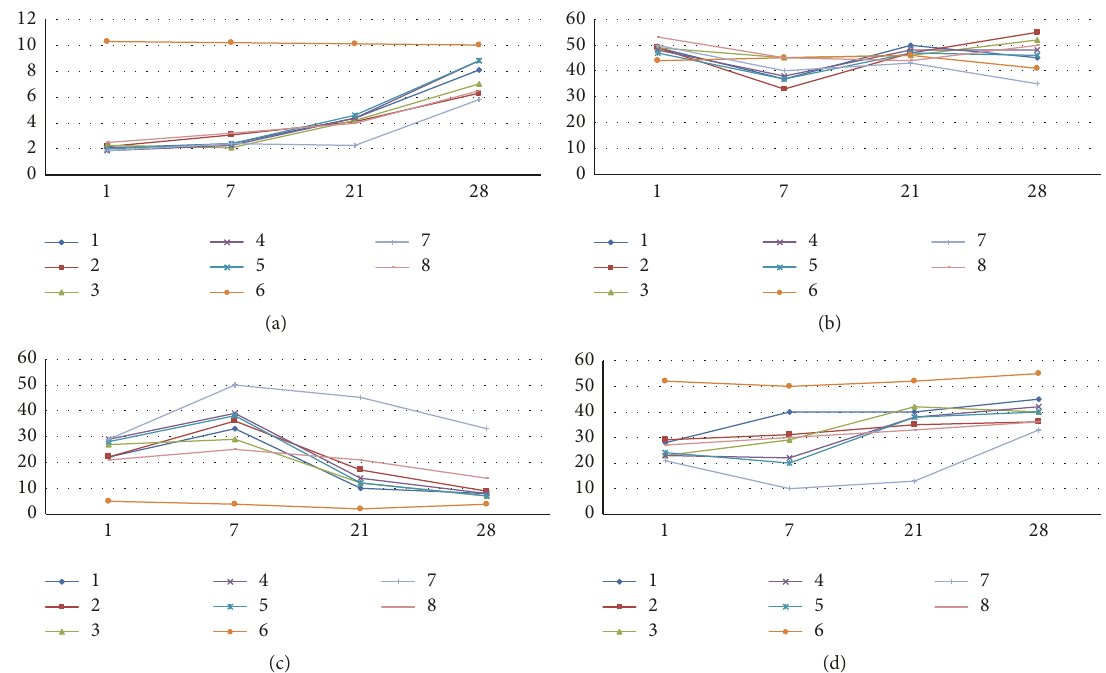
Figure 1: The hemogram of peripheral blood: white blood cells count (a), granulocytic cells (b), eosinophilic and monocytic cells (c), and lymphocytes (d) administration of 10 after the injection of cyclophosphamide solution (1), administration of 7 after the injection of cyclophosphamide solution (2), administration of 6 after the injection of cyclophosphamide solution (3), administration of 8 after the injection of cyclophosphamide solution (4), administration of 9 after the injection of cyclophosphamide solution (5), intact animals (6), control group (administration of placebo (saline) after the injection of cyclophosphamide solution) (7), and administration of methyluracil after the injection of cyclophosphamide solution (8). Time in days (the abscissa axis) versus number of cells (the axes of ordinates) ((a) ⋅ 10 9 /L; (b), (c), and (d) %).